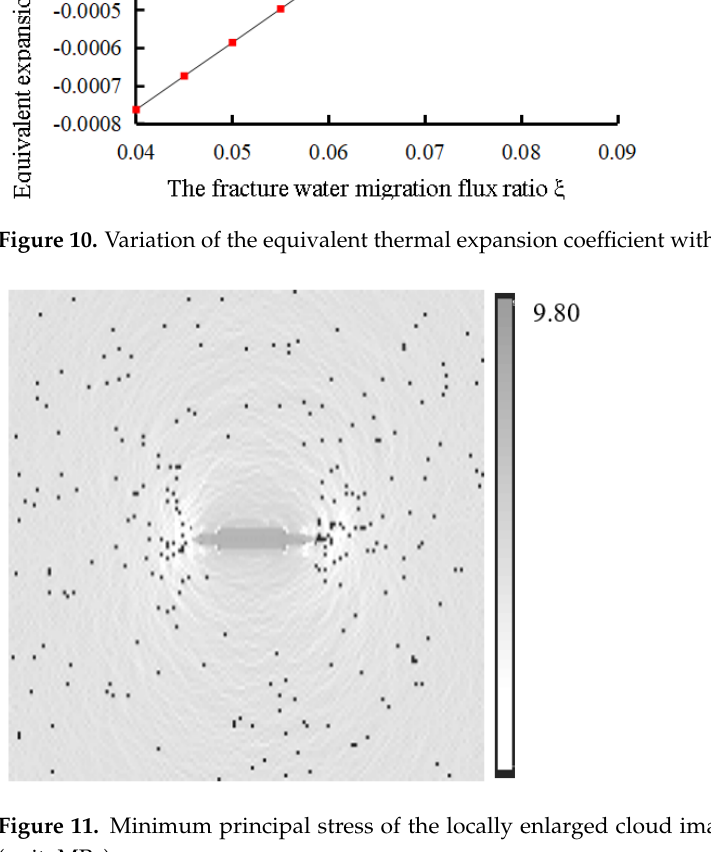
Figure 11. Minimum principal stress of the locally enlarged cloud image at the time of ξ = 0.06 (unit: MPa).